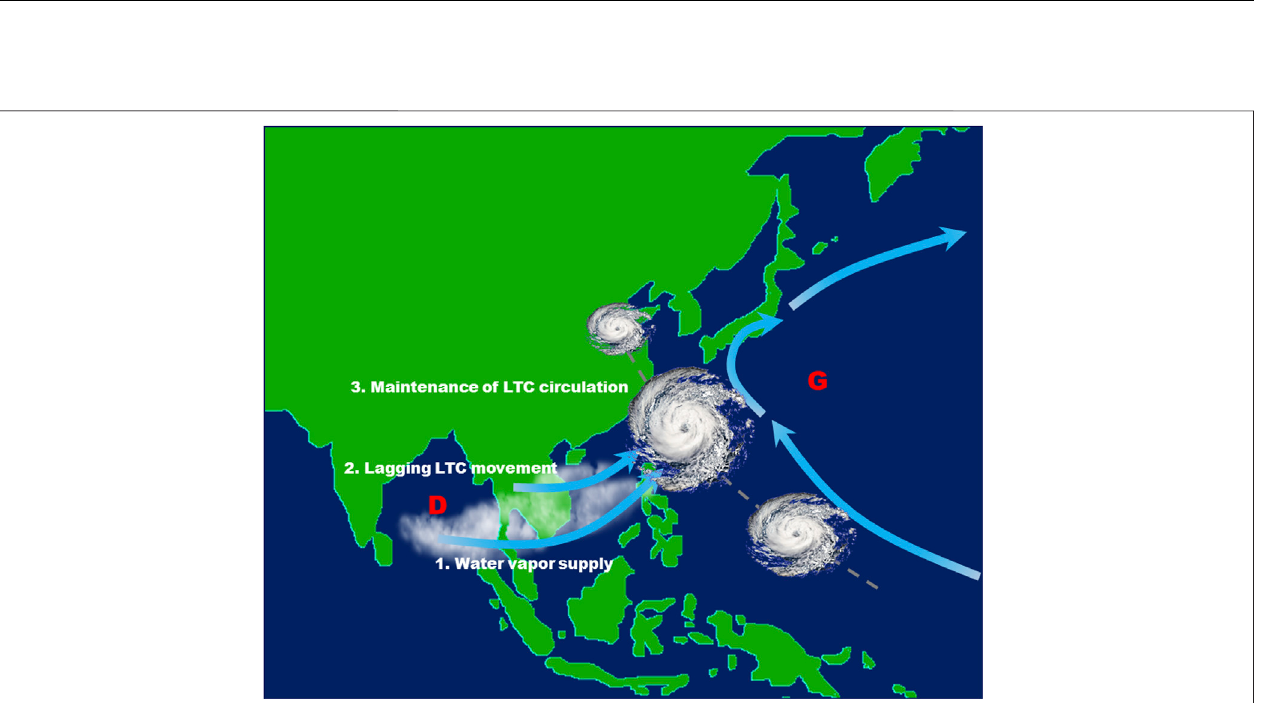
Frontiers in Earth Science |